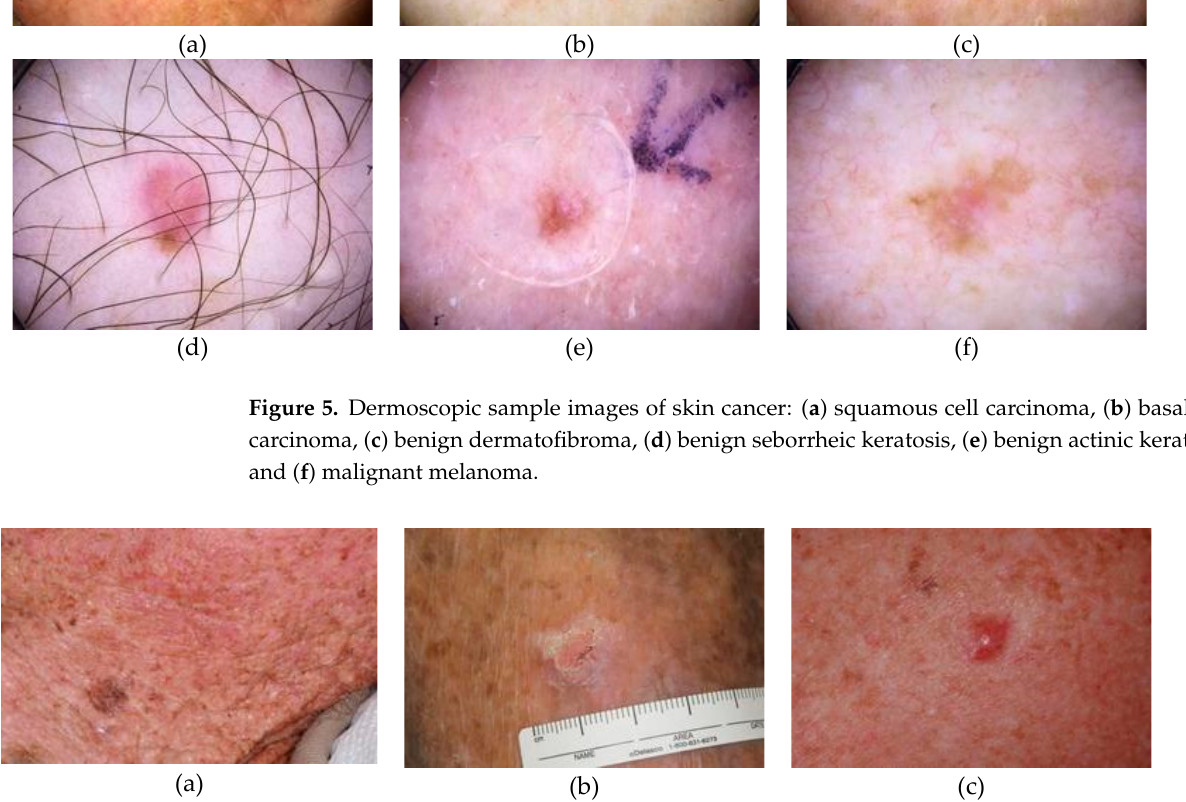
Figure 6. Clinical sample images of skin cancer: ( a ) malignant melanoma, ( b ) squamous cell carci- noma, and ( c ) basal cell carcinoma.